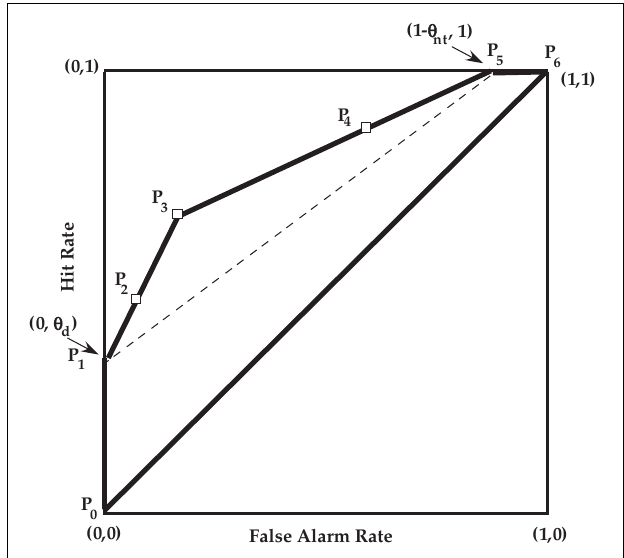
FIGURE 3 | ROC for the PD model. See Table 3 for a description of the points P i , i = 0 , ··· , 6. The open squares are the three theoretical “operating” points, and the extrema points are P 1 = (0 , θ d ) and P 5 = (1 − θ nt , 1).